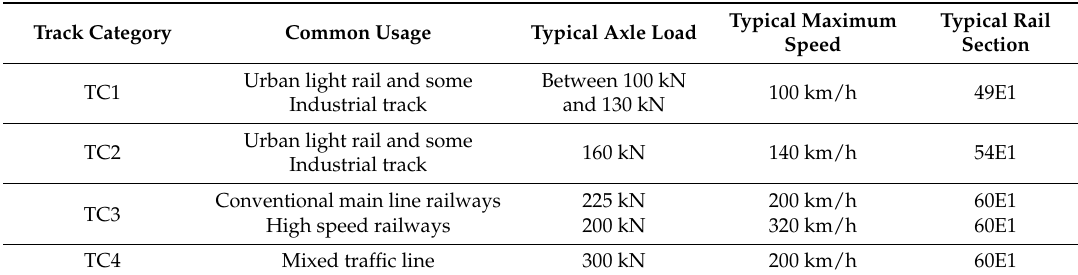
Table 7. Track category in